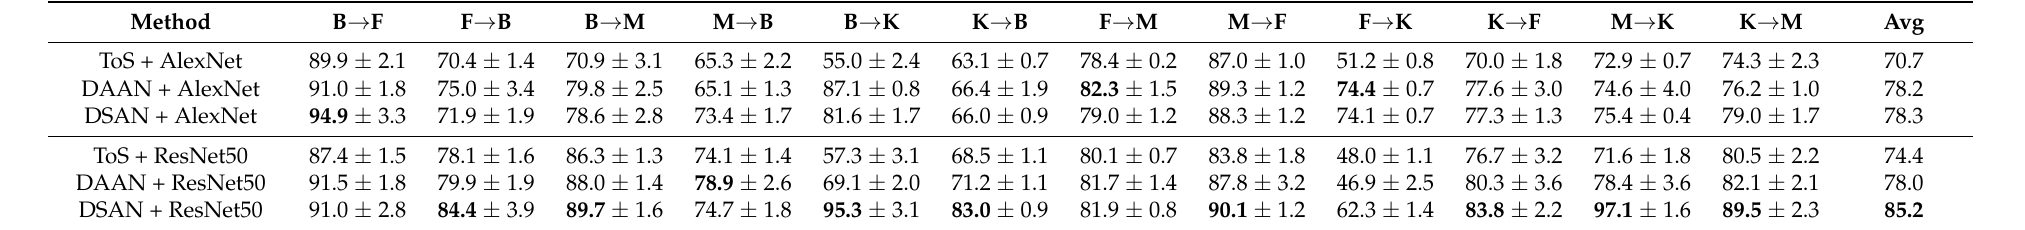
Table 2. Accuracy (%) on Fire-DA for unsupervised domain adaptation. The values show the average classification accuracy with five random experiments and the standard